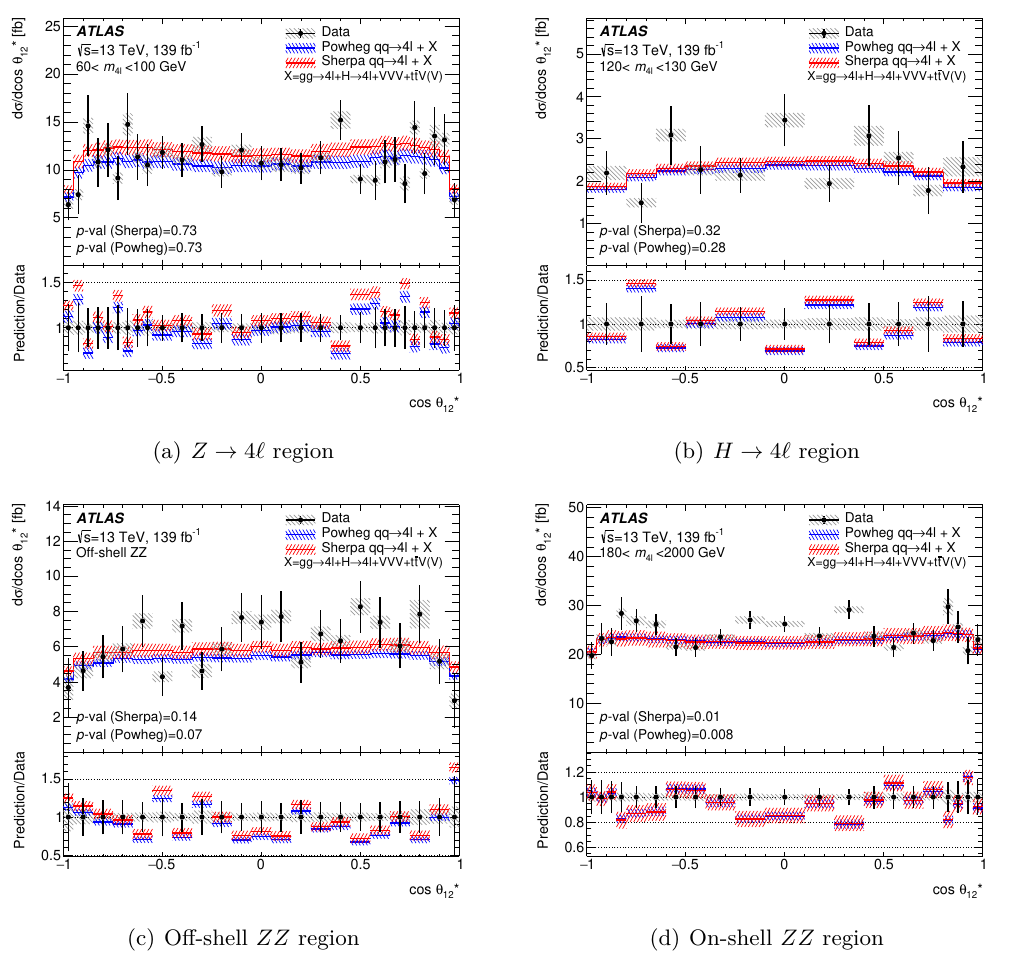
in the four m regions. The measured Figure 10 . Differential cross-section as a function of cos θ ∗ 4 ‘ 12 data (black points) are compared with the SM prediction using either Sherpa (red, with red hashed band for the uncertainty) or Powheg + Pythia8 (blue, with blue hashed band for the uncertainty) to model the q ¯ q → 4 ‘ contribution. The error bars on the data points give the total uncertainty and the grey hashed band gives the systematic uncertainty. The p -value is the probability for the χ 2 , with the number of degrees of freedom equal to the number of bins in the distribution, to have at least the observed value, given the SM prediction. The lower panel shows the ratio of the SM predictions to the